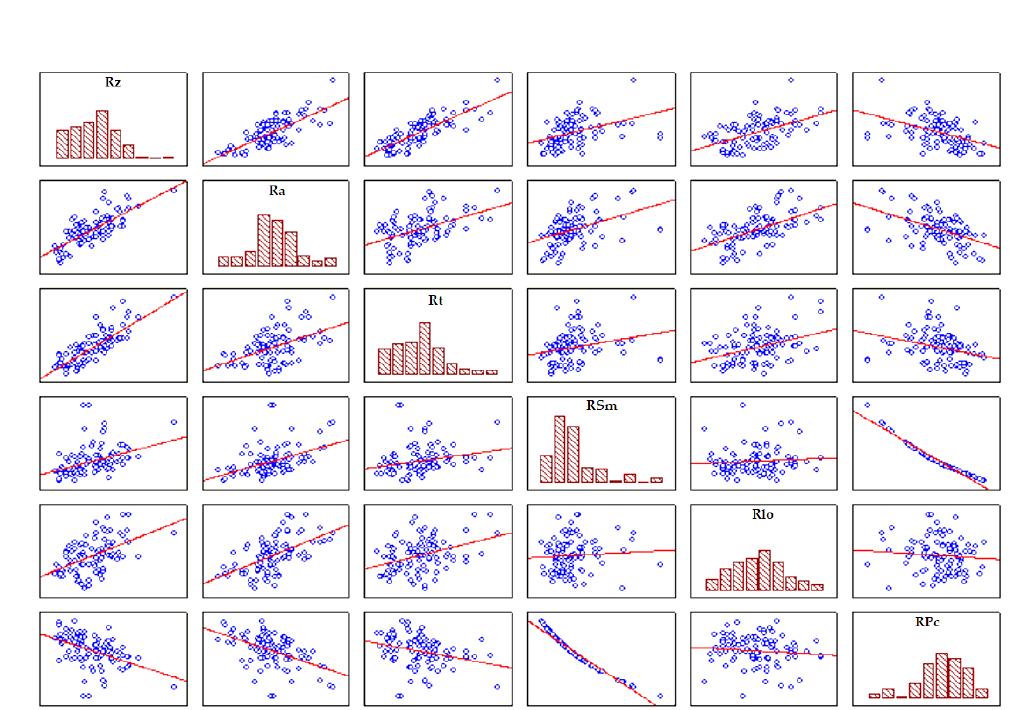
Figure 11. The correlation matrix and the graphs for the DSS.